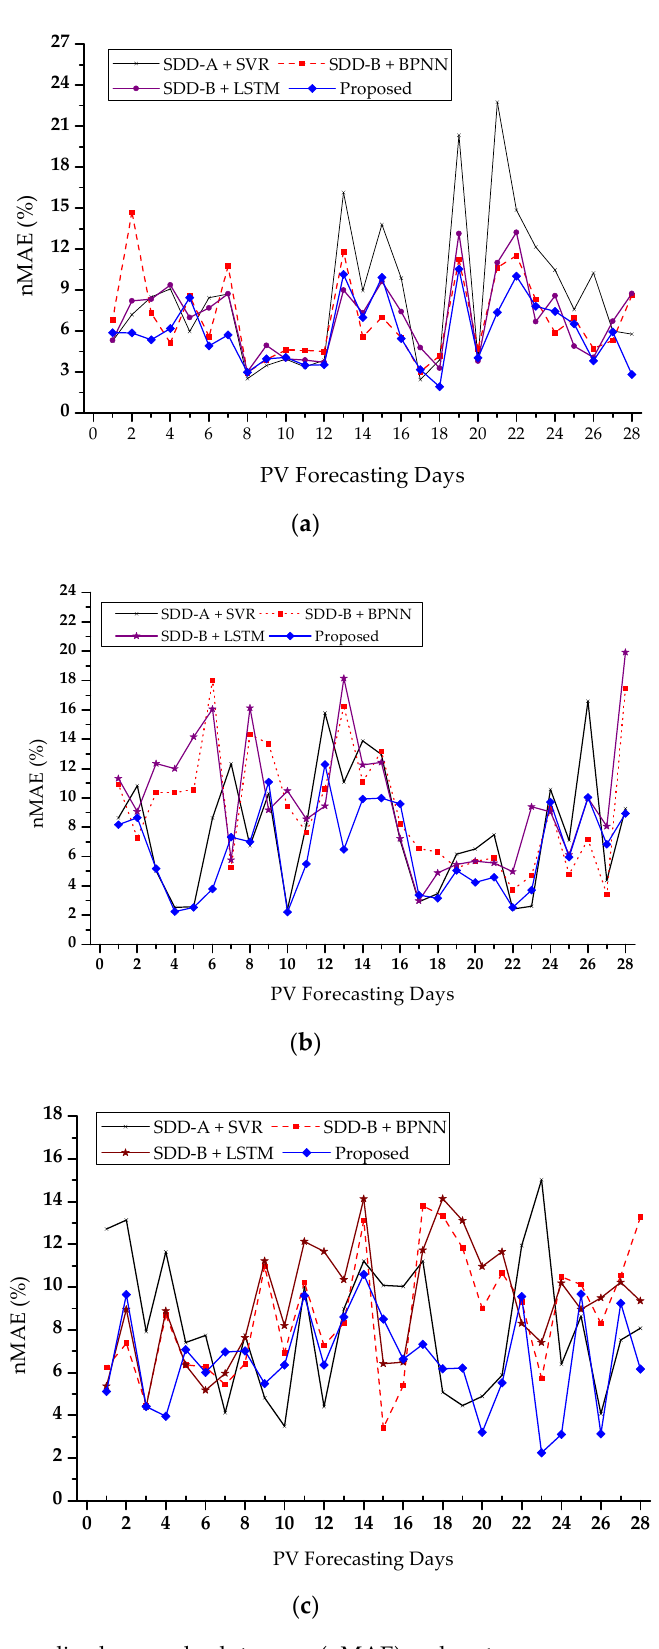
Figure 8. Daily normalized mean absolute error (nMAE) and root-mean-square error (RMSE) of PV power forecasting with different SDD methods. ( a ) Summer, ( b ) autumn, and ( c ) winter.